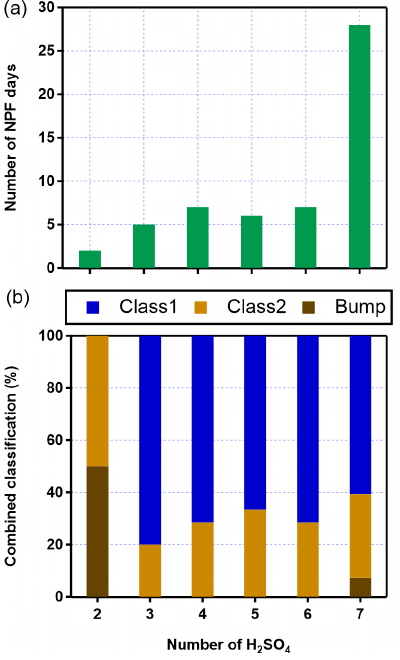
(cid:113) NO − cluster ions 3